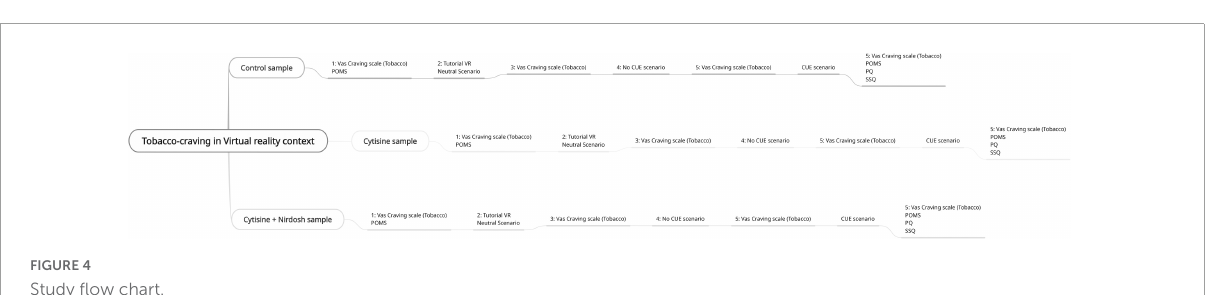
FIGURE4 Study flow